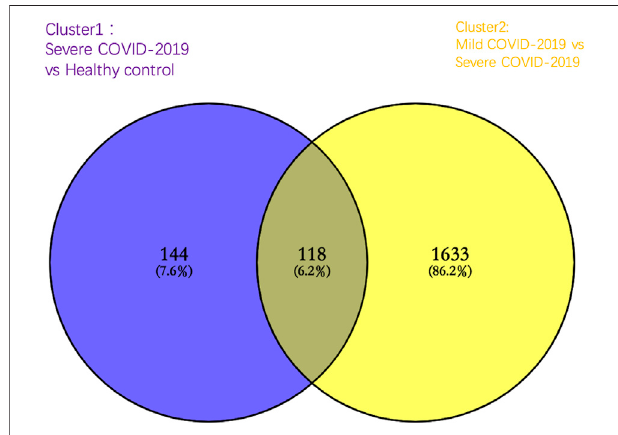
FIGURE 2 | Venn diagram of signi fi cantly altered genes in cluster 1 [severe COVID-19 group compared with healthy control group (purple)] and cluster 2 [mild COVID-19 group compared with the severe COVID-19 group (yellow)]. A total of 144 genes were signi fi cantly altered speci fi cally in severe COVID-19 patients.